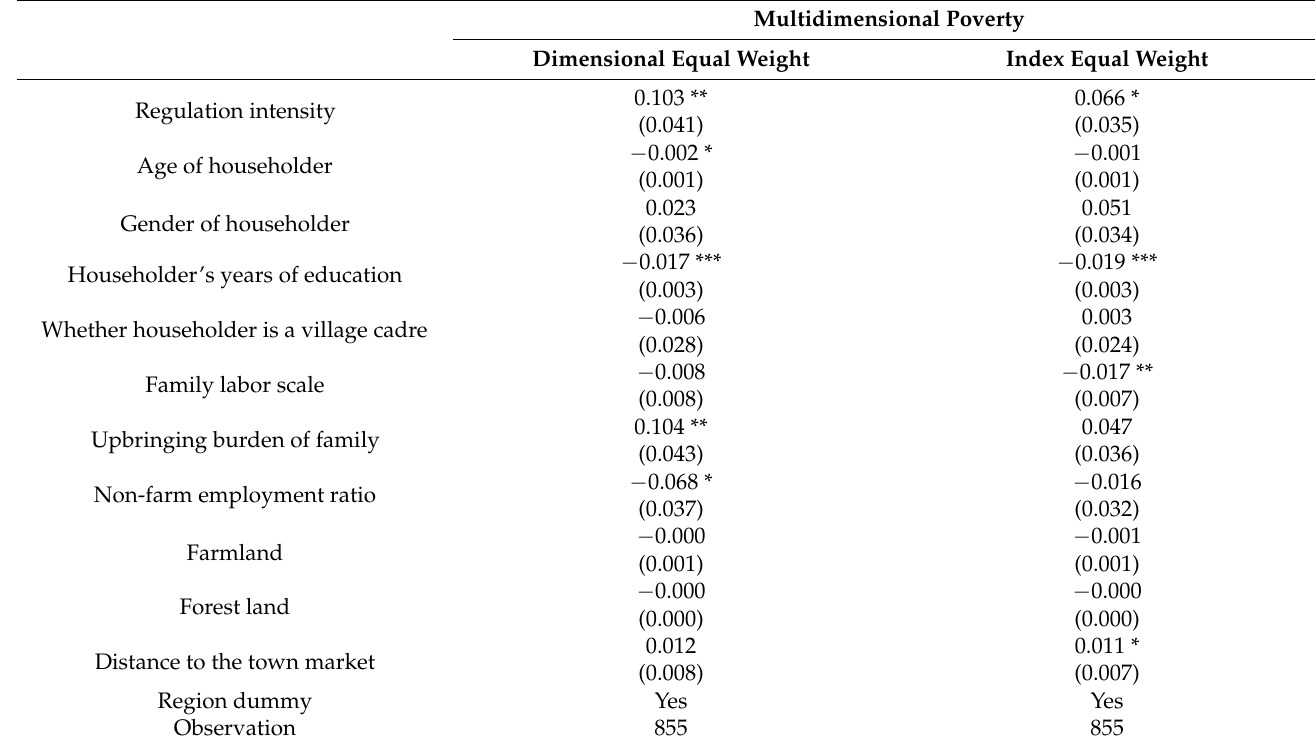
Table 7. Robust check 1: using new dependent